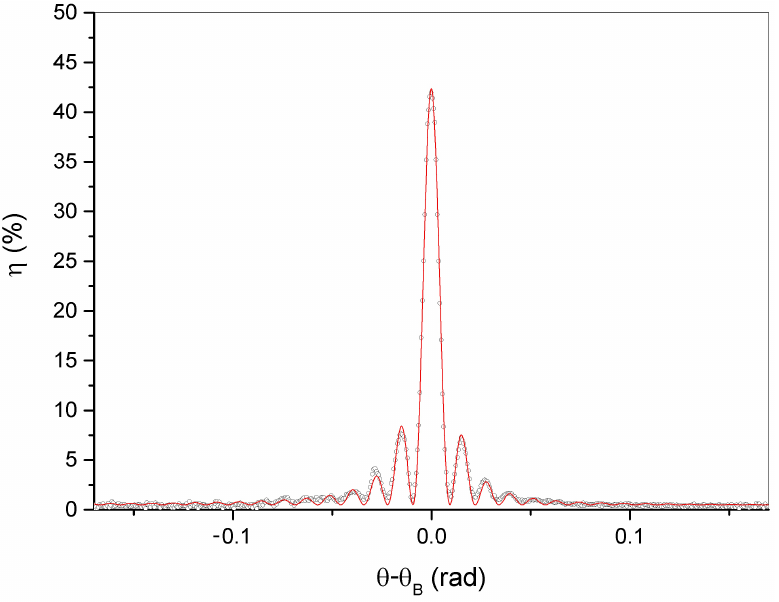
Figure 3. Angular selectivity measurement taken at λ = 632 nm. The experimental data fit, reported in red, is made by using Equation